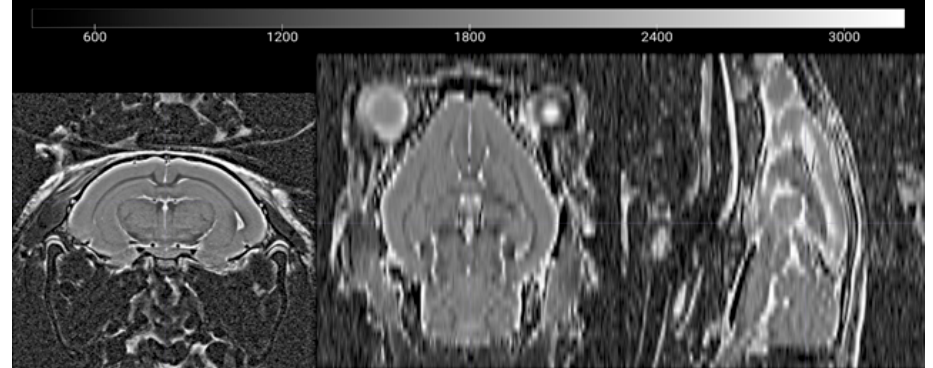
Figure A1. Example of T2 Volumetric Images. Representative T2-weighted image showing coronal, sagittal, and axial views of an adolescent guinea pig brain. Left–right orientation is as shown in the coronal image, the anterior (rostral) portions of the brain face upwards in the sagittal and axial views. Image created in MRIcroGL v1.2.